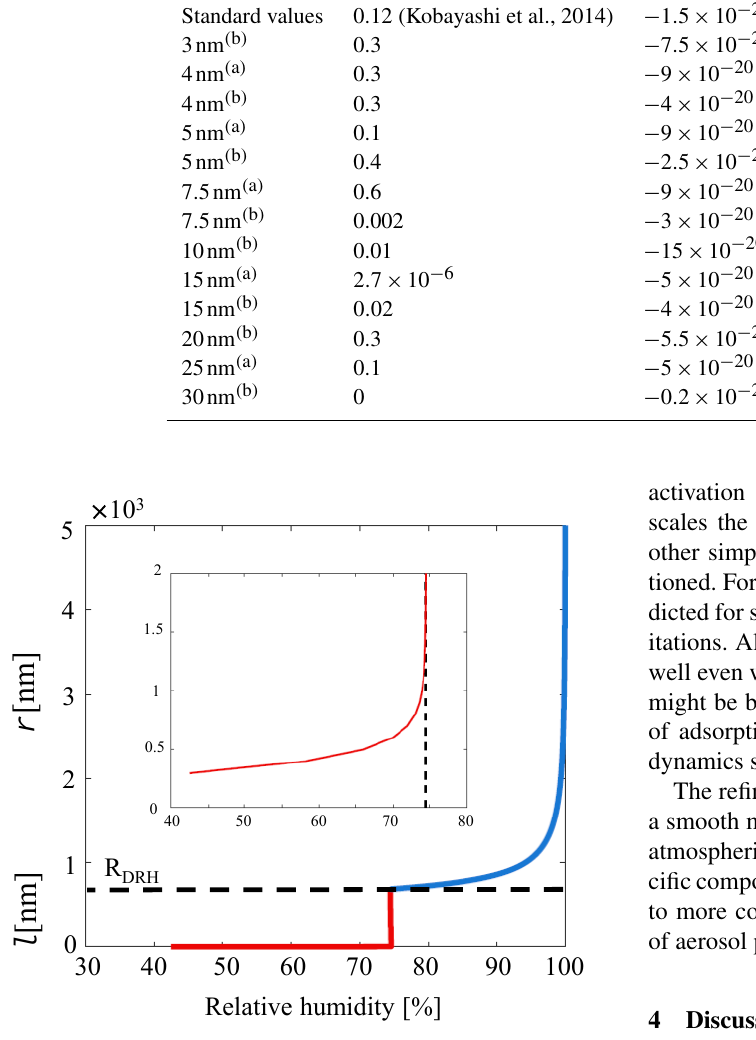
Figure 3. Model of the growth of the solvating surface of a 0.8µm accumulation mode NaCl particle as outlined in the text. Below deliquescence ( (cid:46) 75%RH and and in the inset, zoomed plot) the metastable brine layer behavior is governed as in Eq. (10) – red curve. Above deliquescence the layer thickness l becomes the ra- dius r of the growing solution droplet as is captured by classical Köhler theory (Eqs. 1–4 and Eq. 10 for r (cid:48) = r , where the interfacial term has vanished – blue